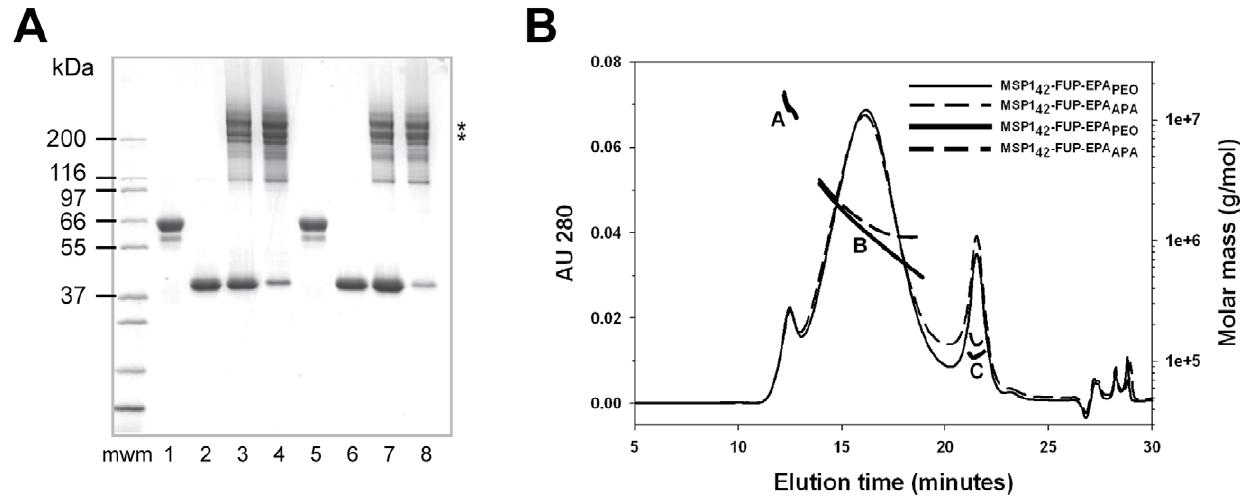
Figure 4. Characterization of MSP1 42 -FUP-EPA conjugates. Panel (A) Coomassie blue stained SDS-PAGE gel analysis of maleimide-EPA (lanes 1 and 5); monomeric MSP1 42 -FUP (lanes 2 and 6), un-purified conjugation mixture of MSP1 42 -FUP-EPA APA (lane 3), bulk purified MSP1 42 -FUP-EPA APA (lane 4); un-purified conjugation mixture of MSP1 42 -FUP-EPA PEO (lane 7) and bulk purified MSP1 42 -FUP-EPA PEO (lane 8). The asterisks indicate the conjugates with 3:1 and 4:1 ratio. Panel (B) SEC-HPLC-MALS analysis. Solid and dashed lines represent absorbance at 280 nm and molecular mass for MSP1 42 -FUP-EPA PEO and MSP1 42 -FUP-EPA APA , respectively. The capital letters A, B and C indicate the profile peaks of each conjugate.